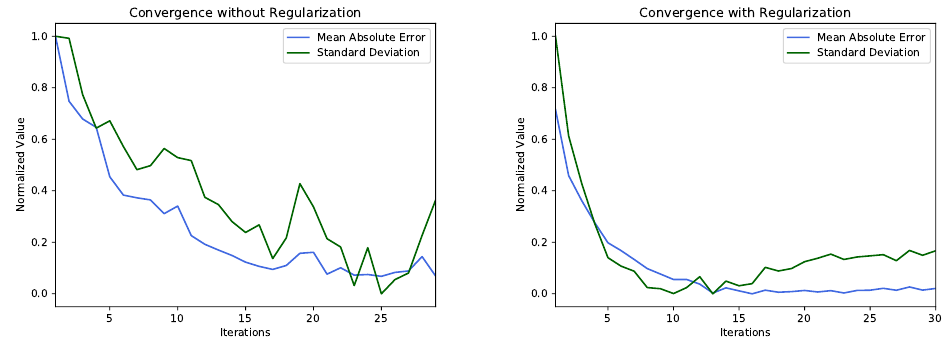
Figure 8. Disaggregation errors together with the standard deviation of the results, with and without using regularization strategies, for the overall amount of national withdrawals.